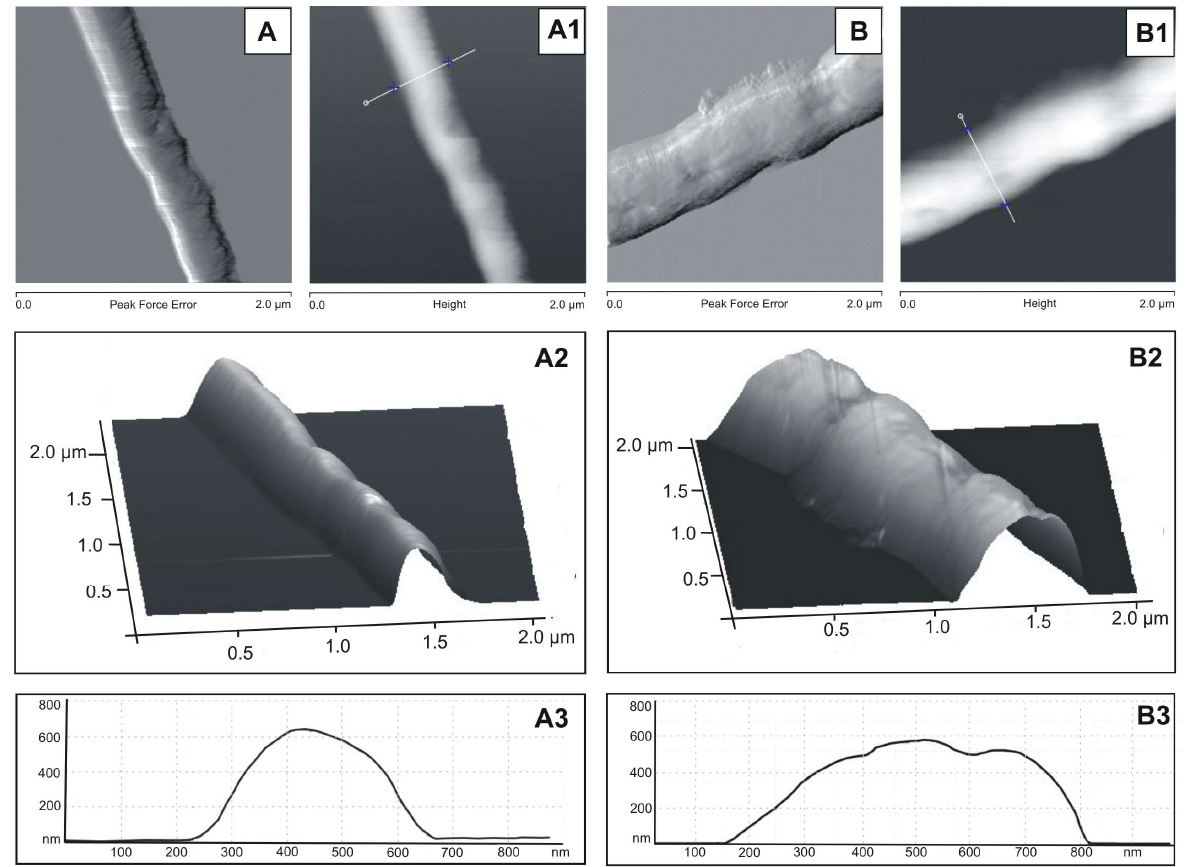
Figure 6. M. smegmatis cell surface imaged by AFM: ( A – A3 )—image of the control M. smegmatis cell surface; ( B – B3 )—image of the M. smegmatis cell surface after 6 days of incubation with 150 µg/mL of the S. hermaphrodita protein seed extract. ( A , B )—general images of cells obtained in the Peak Force mode; ( A1 , B1 )—images of cells obtained in the height mode; ( A2 , B2 )—3D visualization of ( A ) and ( B ) images; ( A3 , B3 )—profile of the mycobacterial cell surface; the profiles were made along the lines shown in the height images.